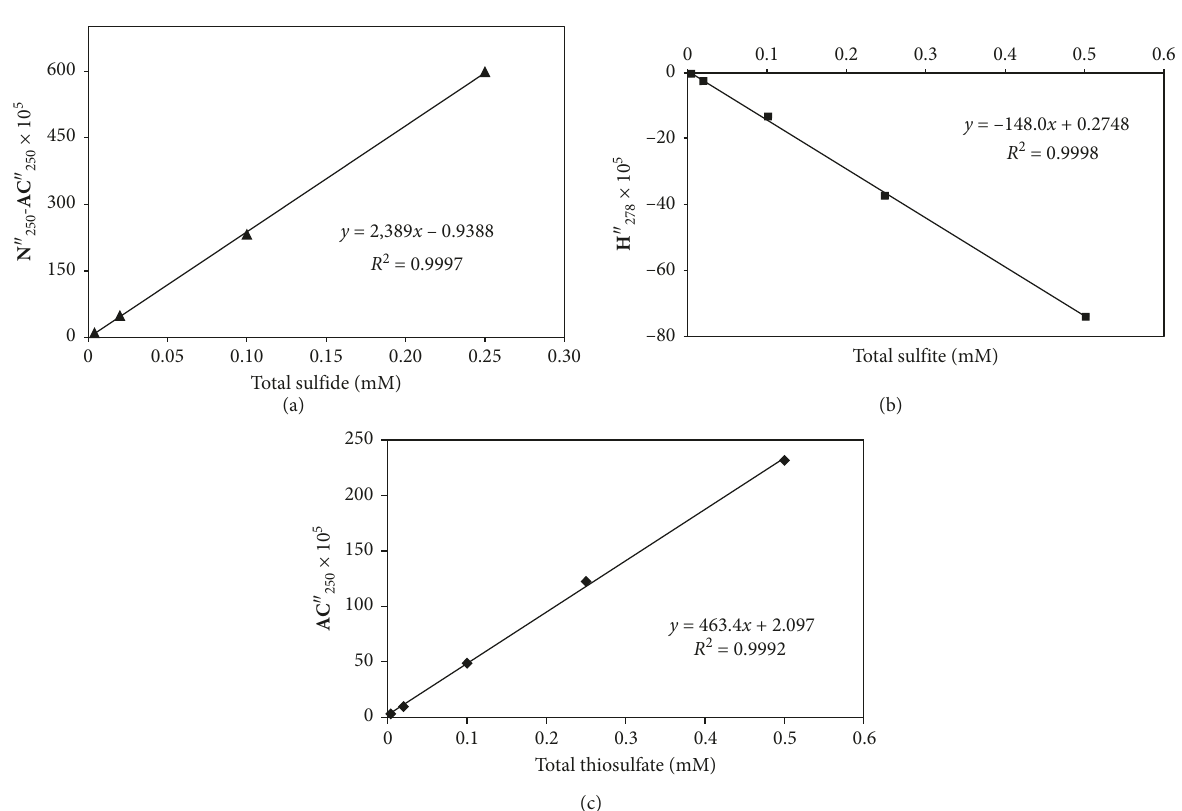
- AC (second-derivative values at 250nm for 250 250 /S 2 ). Values H (second- ″ ″ 278 /SO 32 ) and AC (second-derivative values at 250 nm for − − ″ 250 /S 2 O 32 ) are represented by squares and triangles, − − ″ − −